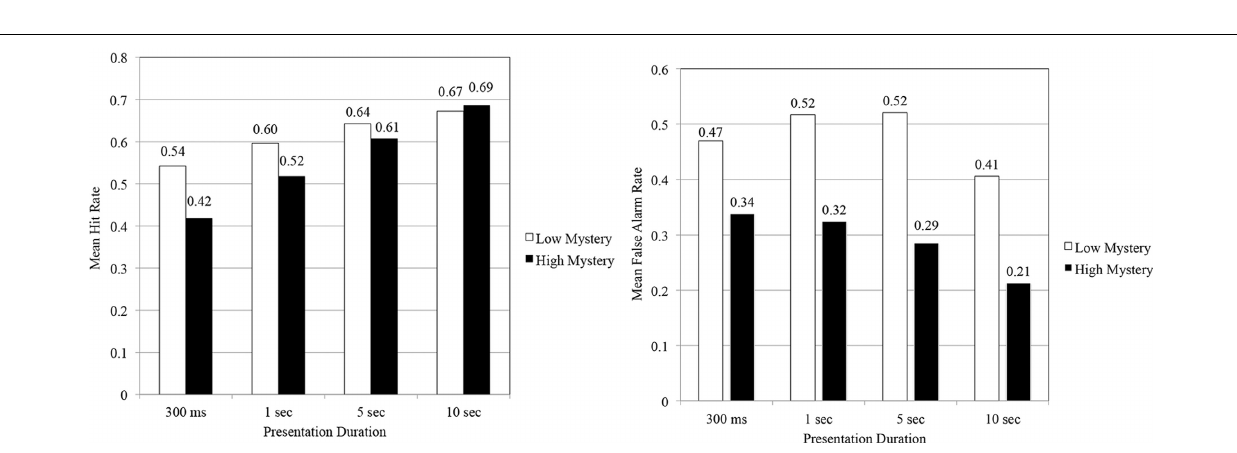
FIGURE 3 | Mean hit rates and false alarm rates as a function of scene type and presentation